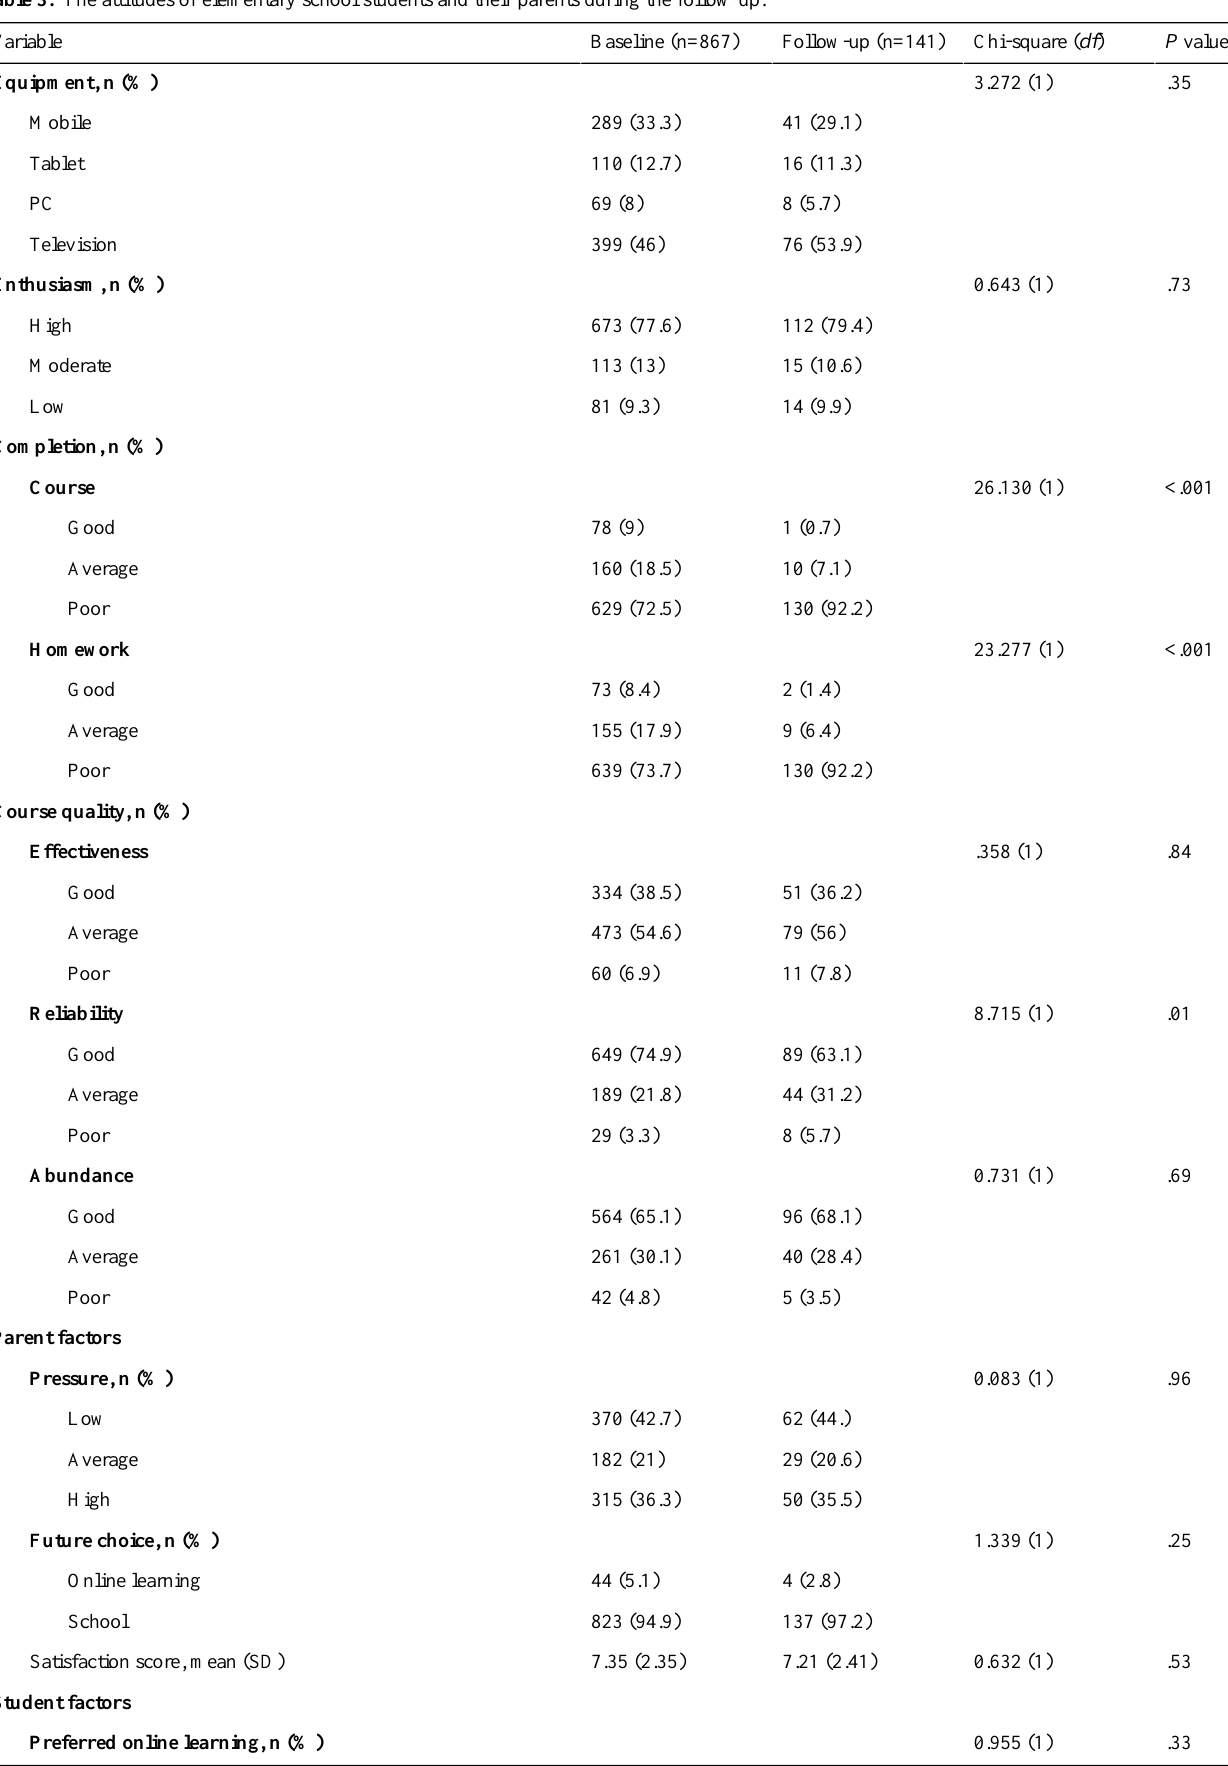
Table 3. The attitudes of elementary school students and their parents during the